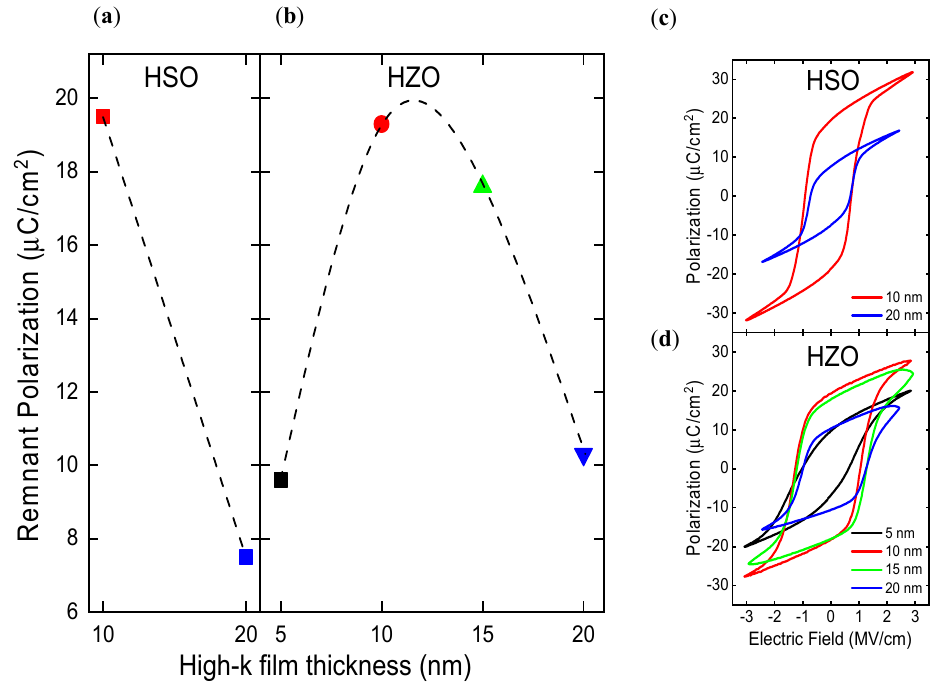
Figure 4. The Pr versus ferroelectric layer thickness for ( a ) HSO and ( b ) HZO using MFM-based capacitors. The corresponding polarization-electric field (P-E) hysteresis ( c , d ) shows a significant P r decrease upon the increase in the ferroelectric thickness. Reproduced with permission from [17] T. Ali et al., IEDM; published by IEEE, Copyright 2019, IEEE.